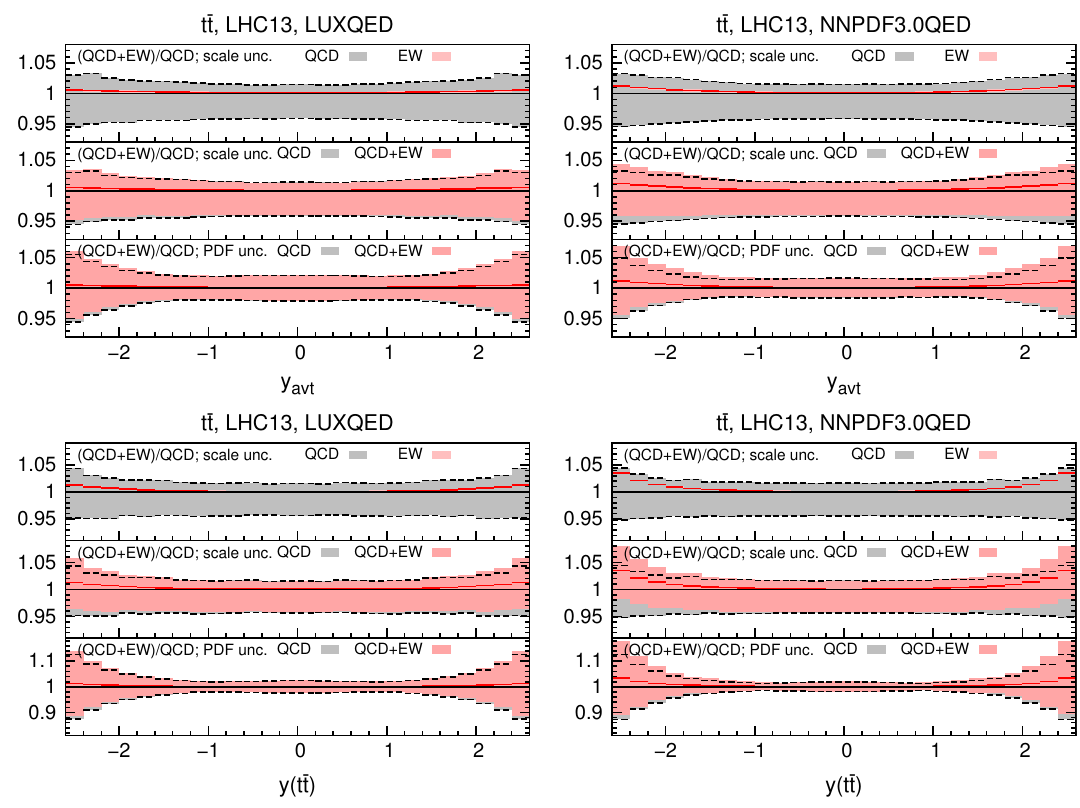
Figure 3 . As in (cid:12)gure 2 but for the y avt and y ( t (cid:22) t ) di(cid:11)erential